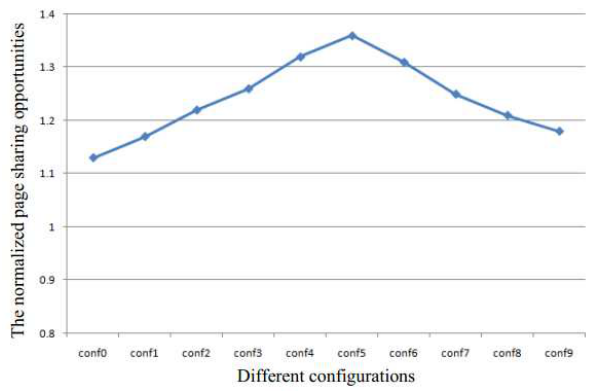
Figure 3. The normalized page sharing opportunities.